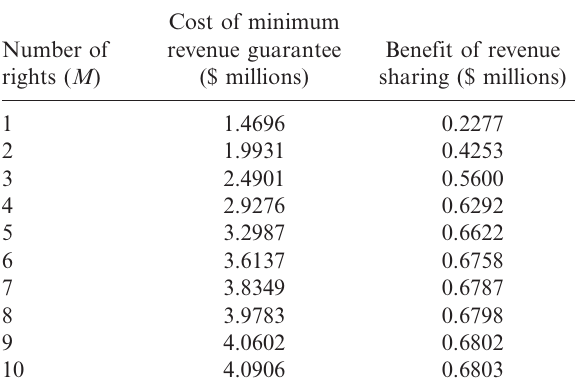
Table 3. Results of the analysis using the new model of government revenue guarantees (Eqns (5) (cid:2)